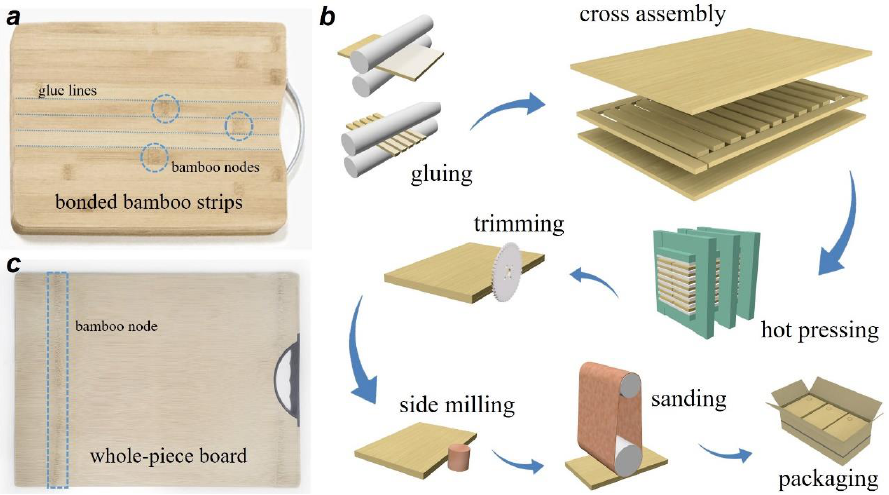
Figure 6. ( a ) Presentative picture of the laminated bamboo chopping board; ( b ) schematic of the production process of FBCB; ( c ) presentative picture of FBCB.